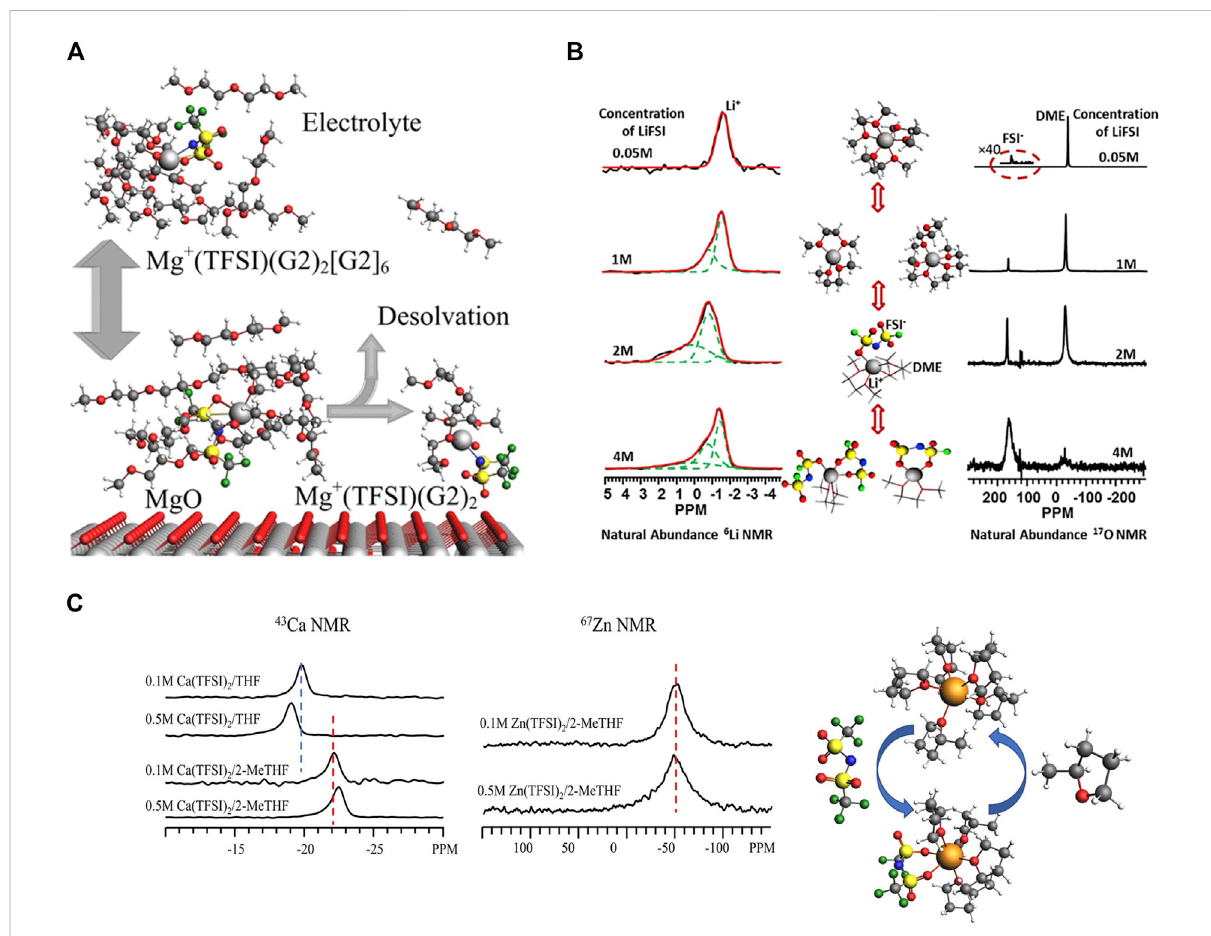
FIGURE 6 (A) Scheme of Mg (TFSI) and G2 adsorption and decomposition on MgO. Reprinted with permission from ref (Hu et al., 2019) . Copyright 2019 American Chemical Society ; (B) 6 Liand 17 ONMR Spectra atdifferentLiFSI concentrations showing changes insolvationstructuresand relevant ppms. Reprintedwith permission from ref (Wan etal., 2016). Copyright © 2015 Publishedby Elsevier (B) V; (C) 43 CaNMR (left) ofCa (TFSI) 2 inTHF and 2-MeTHF and 67 Zn NMR (right) of Zn (TFSI) 2 in THF. Reprinted with permission from ref (Hu et al., 1998). © 2022 Battelle Memorial Institute Published by American Chemical